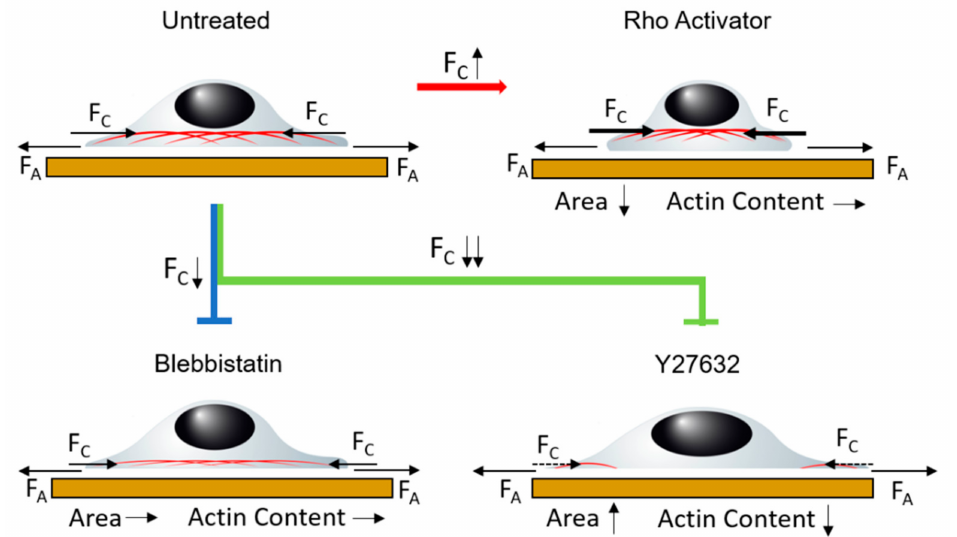
Figure 8. Application of the model of equilibrium between adhesion tension F A and cytoskeleton tension F C in untreated cells. Treatment with blebbistatin and Y27632 as inhibitors and Rho activator as promoter changes the cytoskeleton tension and leads to an imbalance. This changes the height of the actin cytoskeleton and the